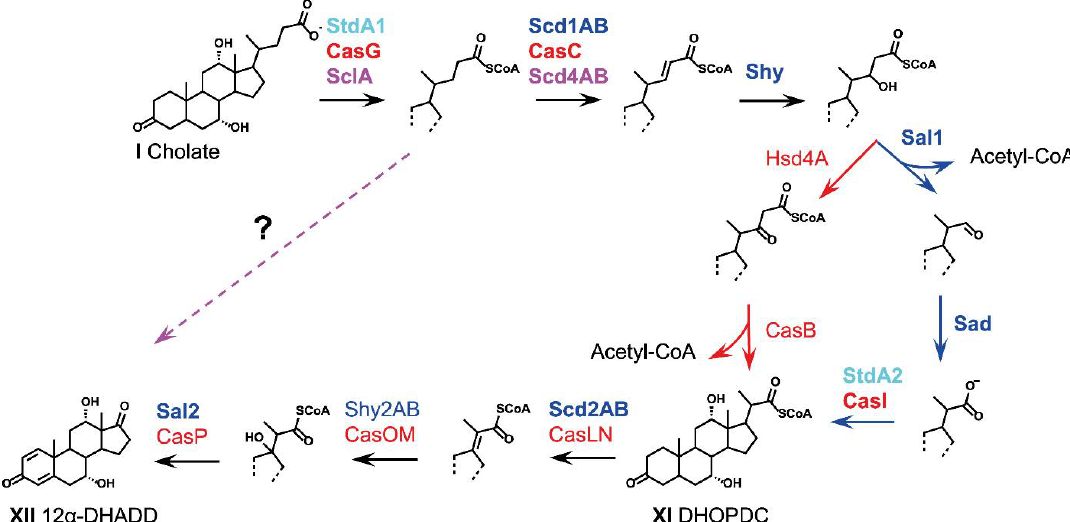
Figure 4. Degradation of the carboxylic C 5 side chain as phase 2 of bacterial bile acid degradation. For bile acids, the respective deprotonated bile salts are depicted. Text and arrow colors indicate the organism, in which the respective enzyme has been identified: dark blue, P. stutzeri Chol1; light blue, P. putida DOC21; green, C. testosteroni TA441; red, R. jostii RHA1; magenta, Sphingobium sp. strain Chol11; black arrows, found in several organisms; dotted magenta arrow, so far unknown side-chain degradation pathway in Sphingobium sp. strain Chol11 and other Sphingomonadaceae . Abbreviations: DHOPDC, 7,12-Dihydroxy-3-oxo-pregna-1,4-diene-carboxylic acid; 12 α -DHADD, 7 α ,12 α -Dihydroxy-androsta-1,4-diene-3,17-dione.